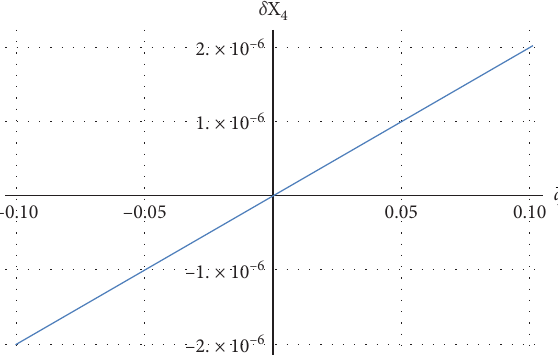
Figure 6: The variation of L specific charge.